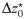
Estimation of mean first-passage time to proximity by approximating fluid dynamics with reduced stochastic process.The full fluid dynamics simulation produces parameters for single membrane and two membranes (Figs 2C, 2D and 3C, 3D, respectively) that are used to parametrize reduced Ornstein-Ulhenbeck models, which are then used to estimate mean first-passage time to separation distance Δz0⋆. For a single membrane with parameters from Fig 2C and 2D, the MFPTs (blue) agree with theoretical results from [50]. For two membranes with parameters from Fig 3C and 3D, the MFPTs (red) increase super-exponentially. Error bars indicate ± one standard deviation of ten independent Weighted Ensemble runs. Gray shading indicates estimated 95% confidence interval based on uncertainty in the estimated OU parameters.